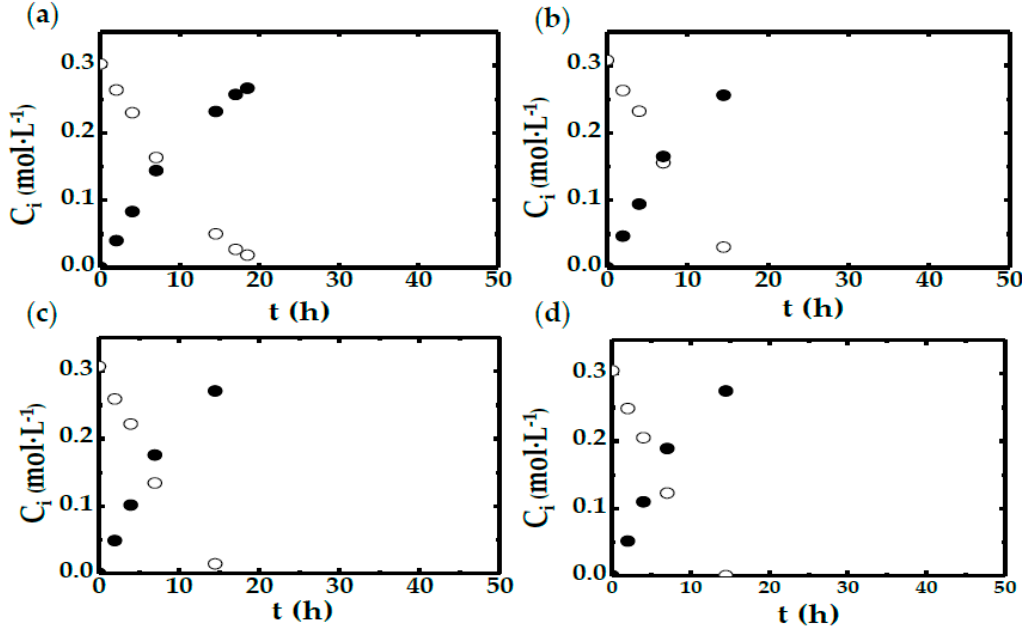
Figure 3. Experimental results. DHA ( ● ) and glycerol ( ○ ) concentrations vs. time for runs 12 to 16 (see Table 1) carried out in shake flasks. All runs conducted at agitation speed of 300 rpm employing different biomass concentrations according to ( a ) 0.3, ( b ) 0.4, ( c ) 0.5, and ( d ) 1.0 g·L − 1 .